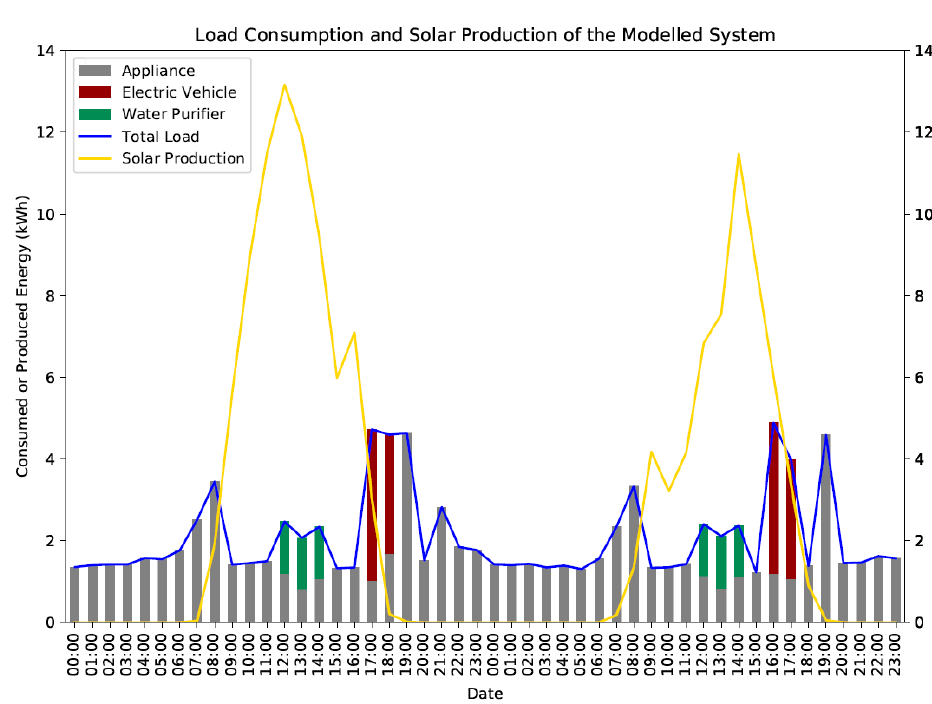
Figure 10. Load scheduling example in March.